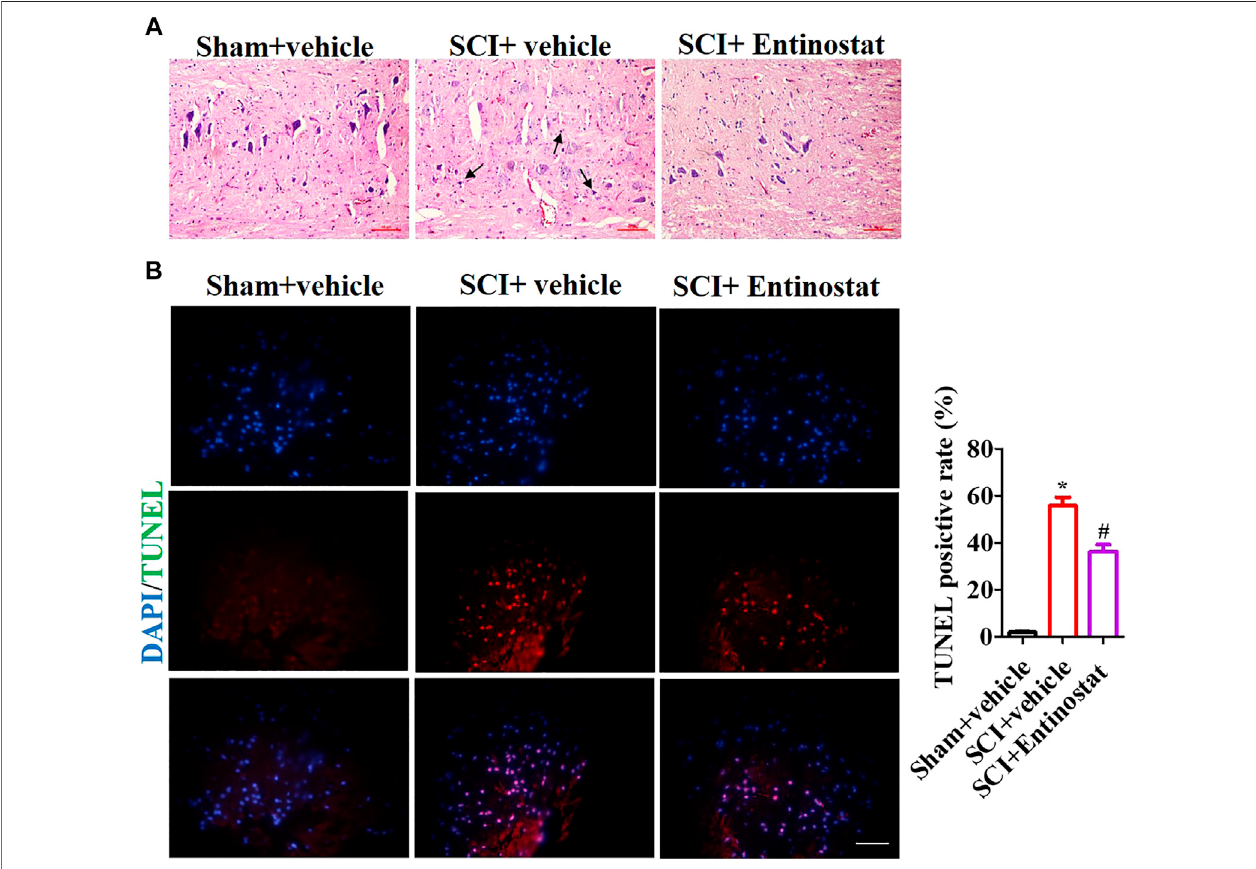
FIGURE 2 | Entinostat attenuates histopathologic damage following SCI. The histopathologic damage was assessed 7 days following SCI by H&E staining. (A) Black arrows indicating the neutrophil in fi ltration and TUNEL staining. (B) Nuclei were stained with DAPI. Histogram analysis of the TUNEL-positive cell. Data are expressed as the mean ± SEM, n (cid:1) 6. Scale bar: 25 μ m * p < 0.05, vs. the sham + vehicle group; # p < 0.05, vs. the SCI + vehicle group.